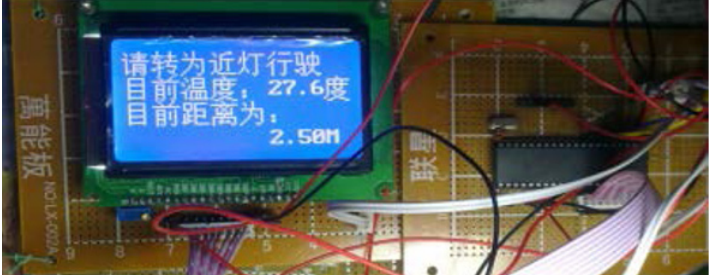
Fig. 4. High beam